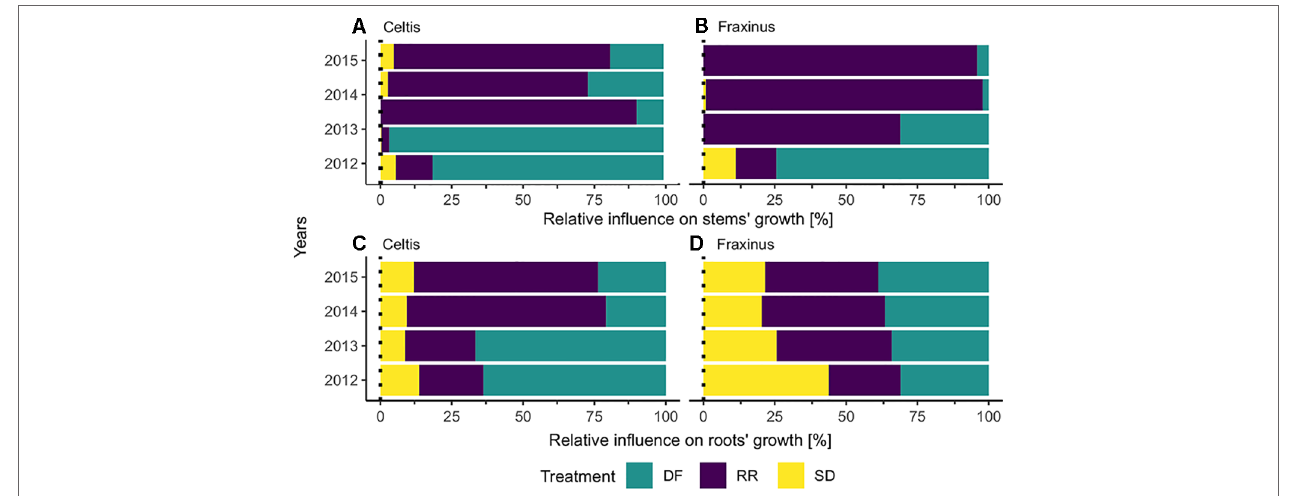
FIGURE 5 | Results from the boosted regression trees: relative influence of each treatment on (A) Celtis and (B) Fraxinus stems, (C) Celtis , and (D) Fraxinus roots, in the years following damage treatment. DF, defoliation; RR, root reduction and SD, stem